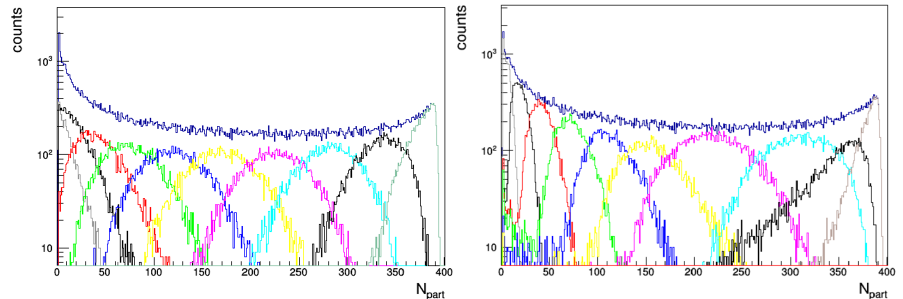
Figure 4. The number of participants’ distributions for the centrality classes determined with the TPC (left) and with the FHCal (right). Each color indicate 10% centrality class determined in FHCal.